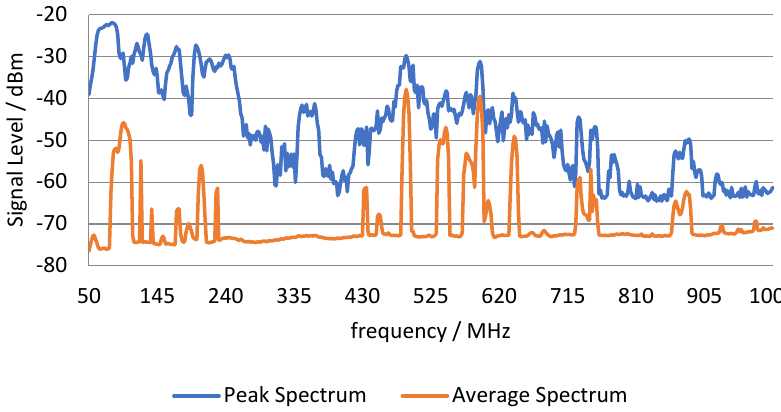
Figure 19. Peak and average spectra.